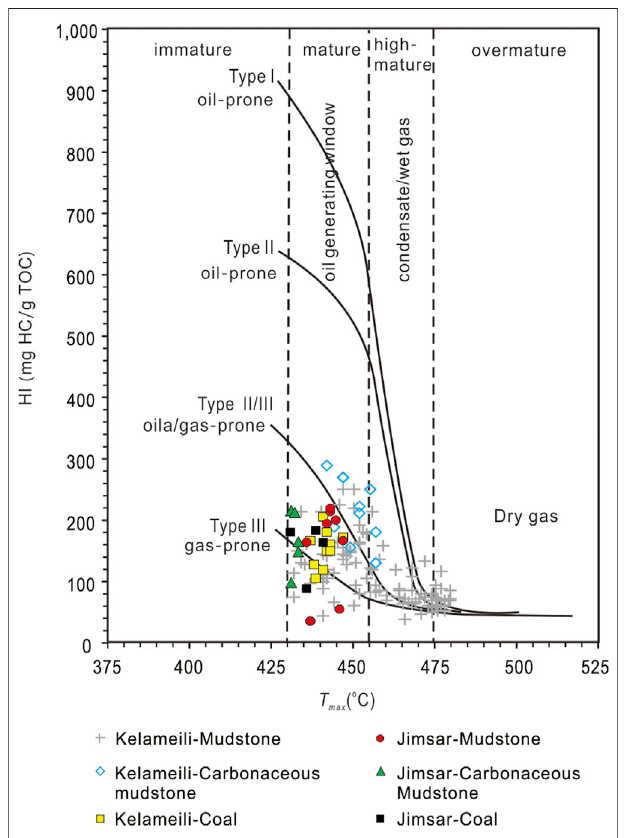
FIGURE3| TheT max vshydrogen index (HI)plotoftheC 1 s b sourcerock in the Jimsar Sag and Kelameili gas fi eld.